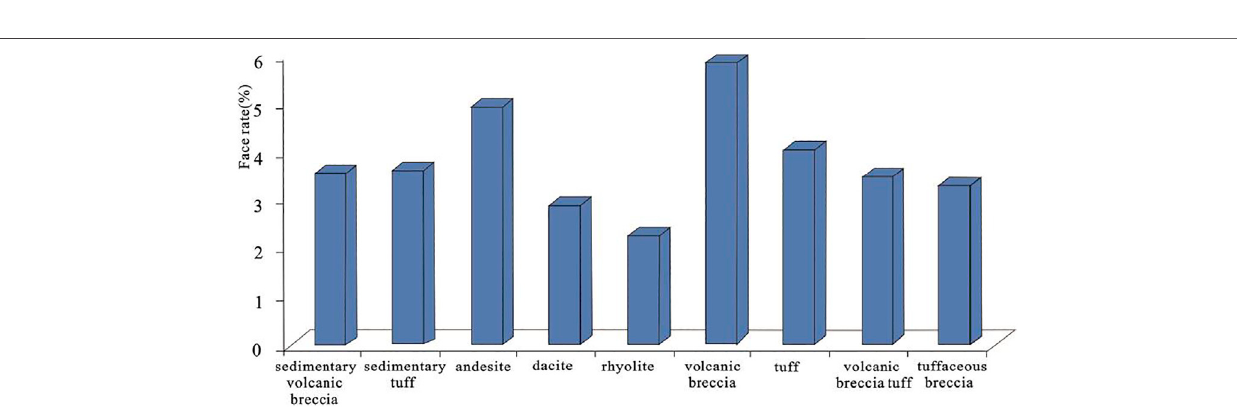
Frontiers in Earth Science |